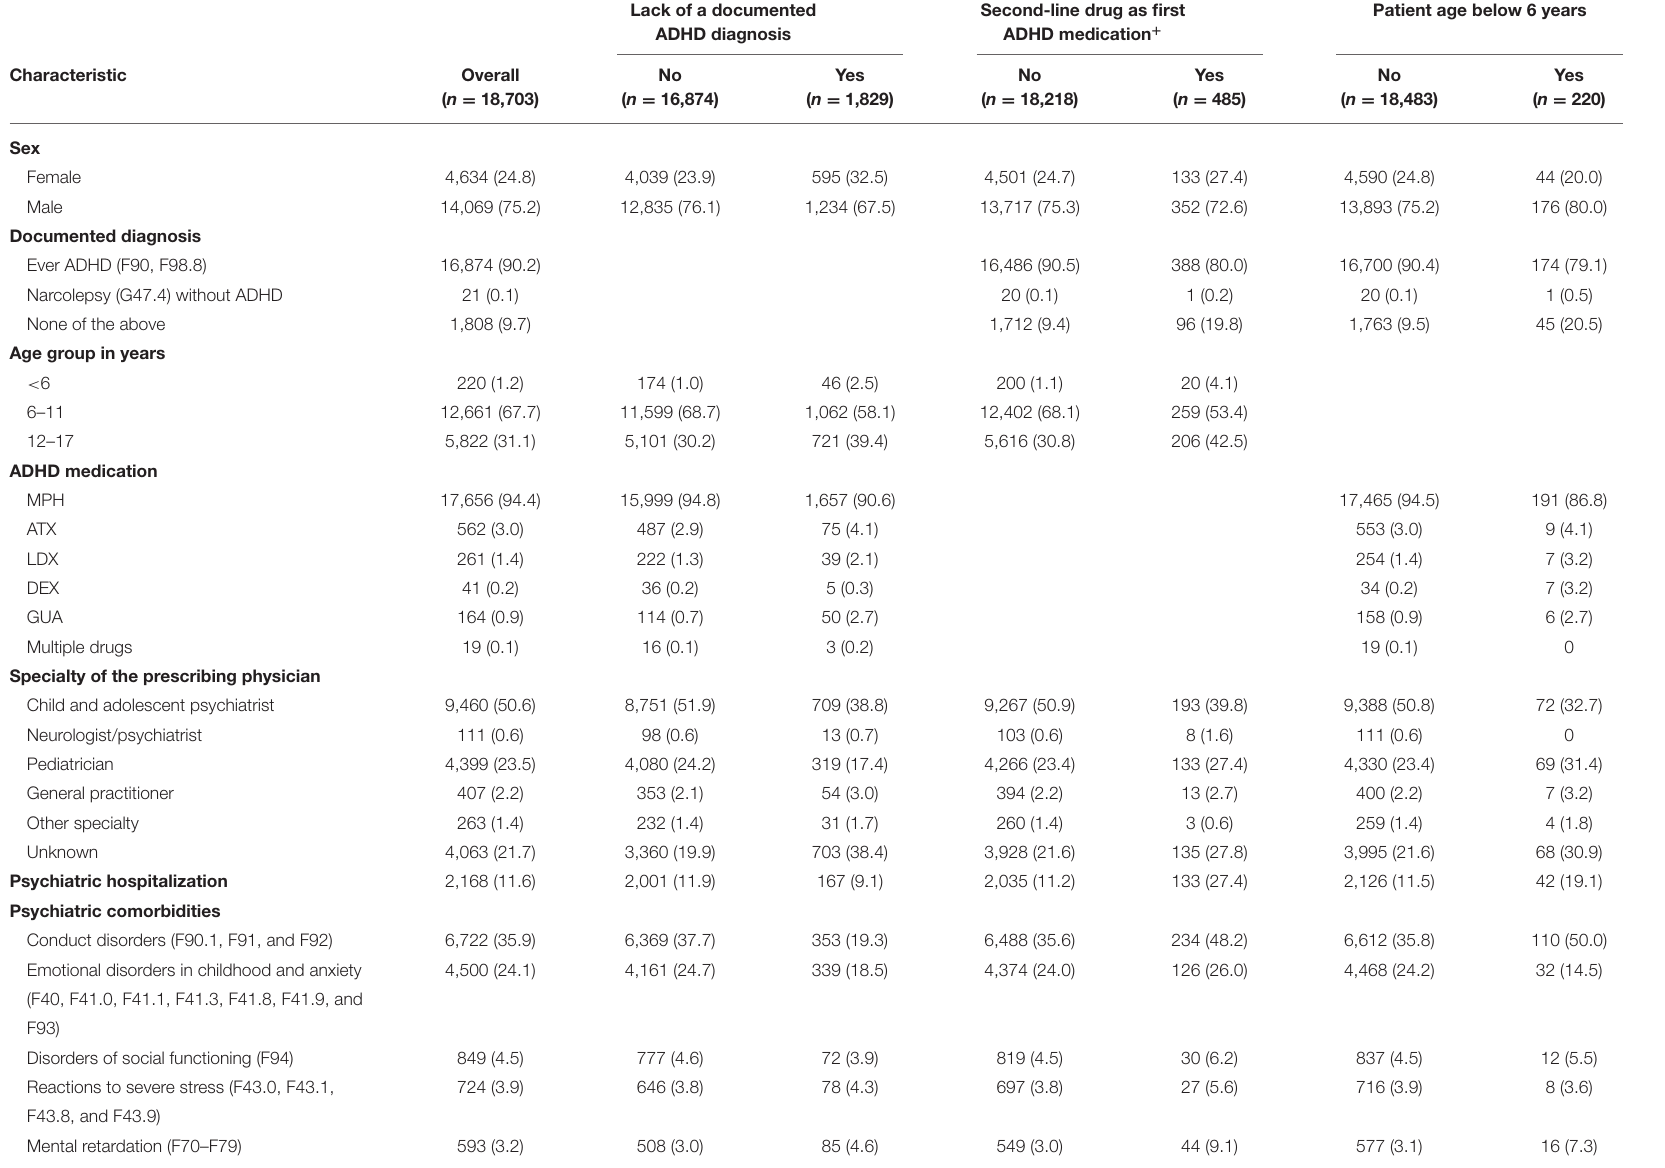
Patient age below 6